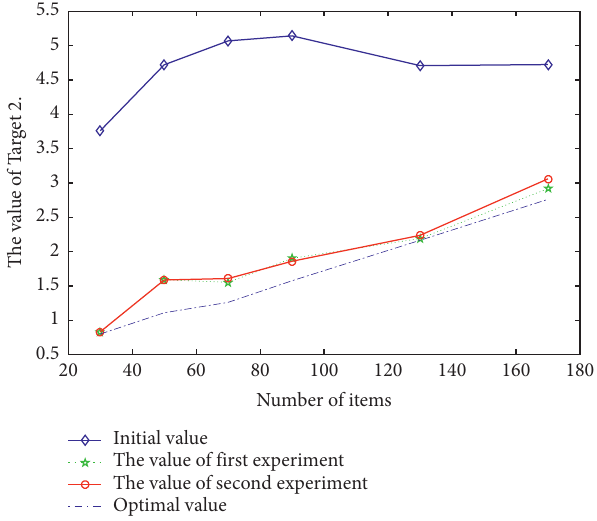
Figure 9: The comparison results of the Target function